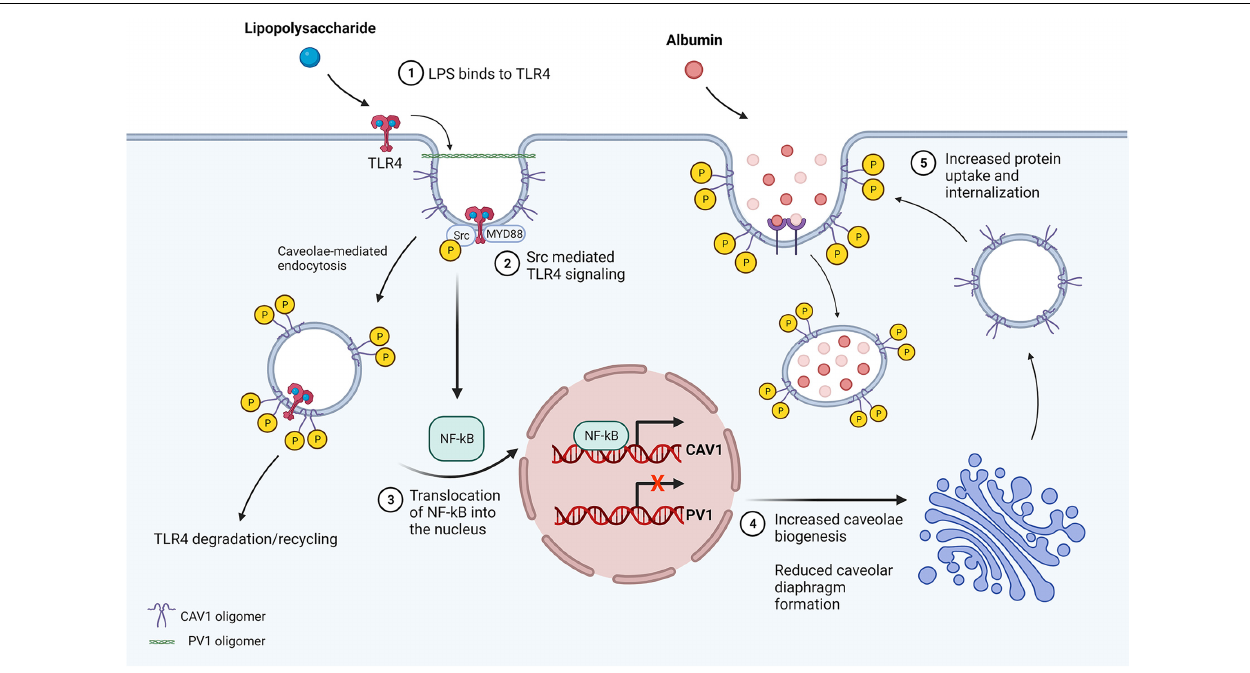
FIGURE 2 | LPS-mediated inflammatory signaling increases transcytosis in endothelial cells. (1) LPS present in the lumen binds to TLR4 in caveolar microdomains. (2) TLR4 signaling activates MyD88 and Src kinase, resulting in caveolin-1 phosphorylation at tyrosine-14 and reduction in caveolin-1 oligomer stability. The vesicle is internalized via dynamin-mediated fission and TLR4 is subsequently degraded or recycled. (3) NF- κ B is activated downstream of MyD88, resulting in translocation of NF- κ B into the nucleus and p65/RelA-mediated upregulation of caveolin-1 expression. LPS also reduces PV1 expression, however, the mechanism through which this occurs is unclear. (4) Upregulation of caveolin-1 increases formation of vesicles, while less caveolar diaphragms are generated due to lack of PV1, which is essential for diaphragm formation. (5) Caveolae traffic to the cell membrane and invaginate, exhibiting wider neck and bulb diameter in the absence of diaphragms resulting in greater filling of the vesicle. Vesicles subsequently undergo fission, contributing to increased protein permeability of the endothelial barrier resulting in protein rich edema formation and